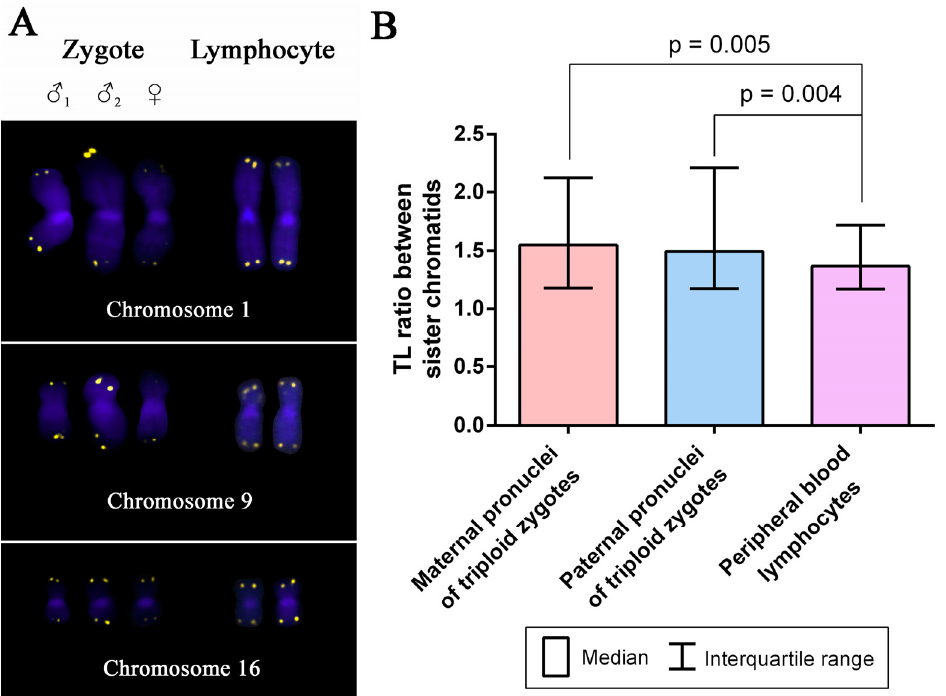
Figure 7. Interchromatid telomere length (TL) difference in metaphase chromosomes of human triploid zygotes and PHA-stimulated lymphocytes. ( A ) Homologous chromosomes 1, 9 and 16 from a triploid zygote with one maternal and two paternal chromosome sets and from a PHA-stimulated adult lymphocyte after fluorescent in situ hybridisation (FISH) with telomeric DNA probes and DAPI-staining. Sister chromatids in zygotic chromosomes show pronounced TL asymmetry. ( B ) Column bar charts of TL ratios between the sister chromatids of chromosomes 1, 9 and 16 within maternal and paternal chromosomes of triploid zygotes and in PHA-stimulated peripheral blood lymphocytes of healthy adult donors. Interchromatid TL difference in maternal and paternal chromosomes in human triploid zygotes is higher than in PHA-stimulated lymphocytes (the Mann–Whitney U test, p = 0.005 and p = 0.004,